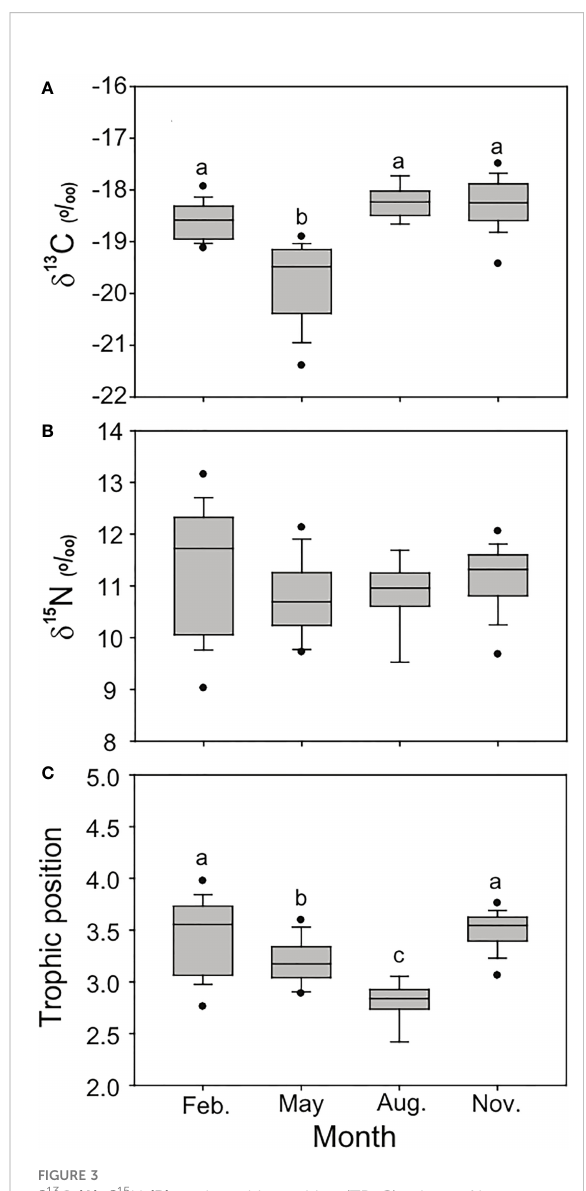
FIGURE 3 d 13 C (A) , d 15 N (B) , and trophic position (TP, C ) values of large- head hairtail ( Trichiurus japonicus ) collected in the South Sea of Korea during February (Feb.), May, August (Aug.), and November (Nov.) 2021. One-way ANOVA and mean values of d 13 C, d 15 N, and TP values for large-head hairtail among four